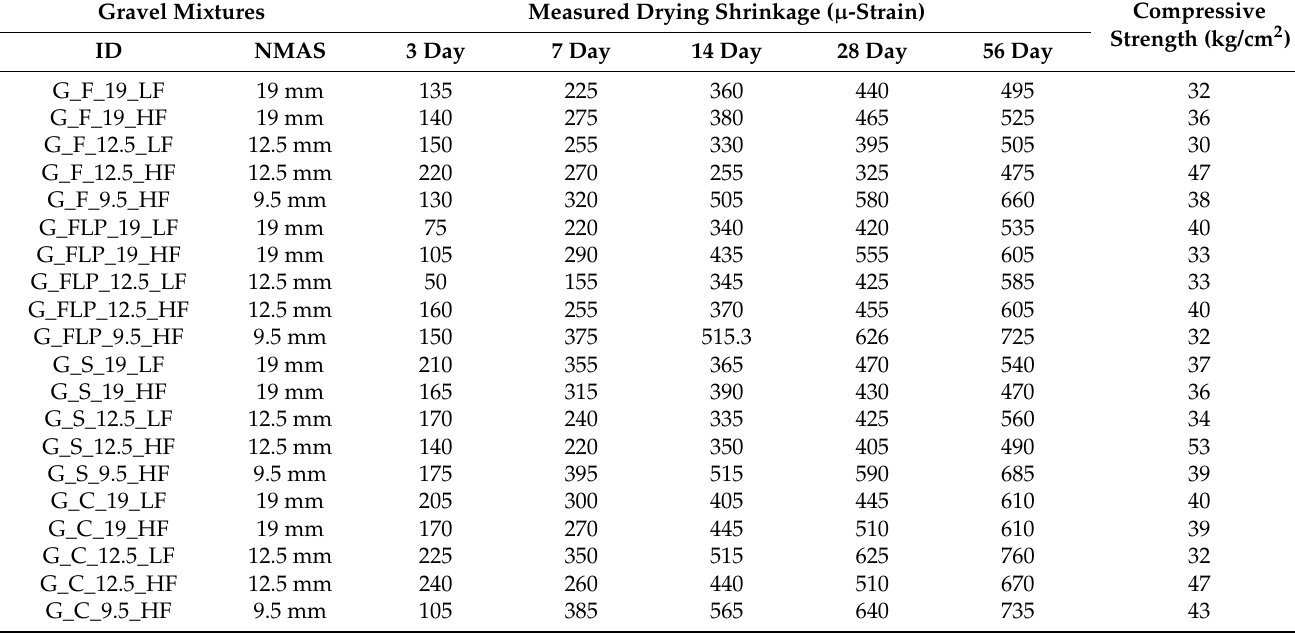
Table 10. Measured drying shrinkage of SCC mixtures containing gravel aggregate (25 mm = 1 in.; 1 kg/cm 2 = 14.2 psi). Gravel